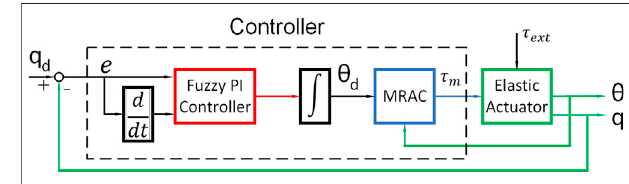
FIGURE 4 | The proposed two-loop controller.